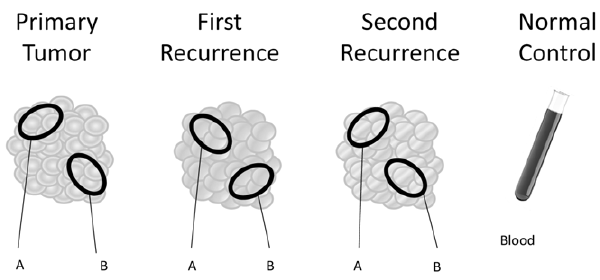
Figure 1. Sample set schematic. This schematic gives a conceptual view of the seven GBM patient samples interrogated in this study. From left to right, we will refer to them in this manuscript as: primary tumor A, primary tumor B, first recurrence A, first recurrence B, second recurrence A, second recurrence B, and